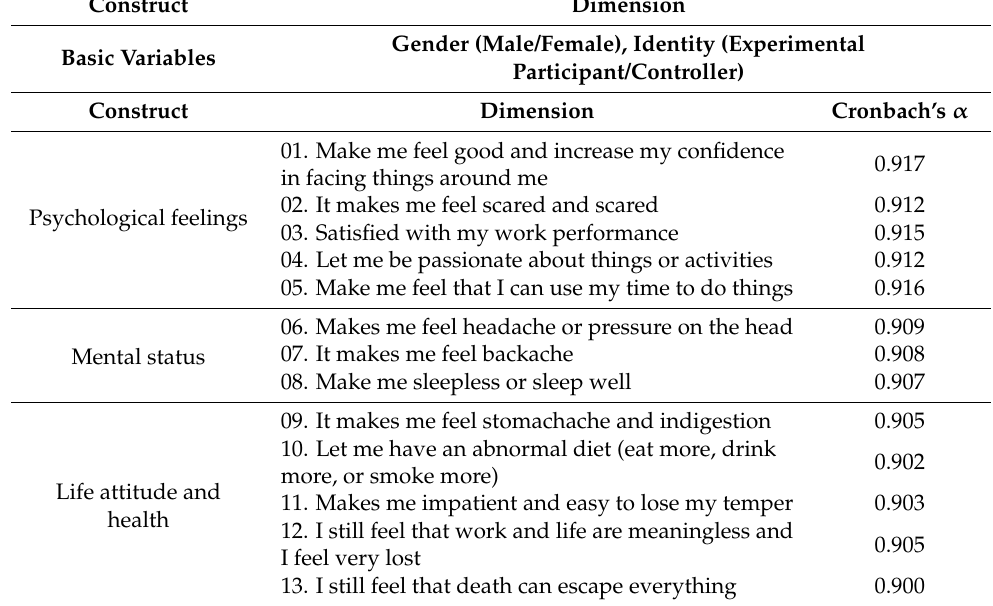
Table 1. Analysis of questionnaire